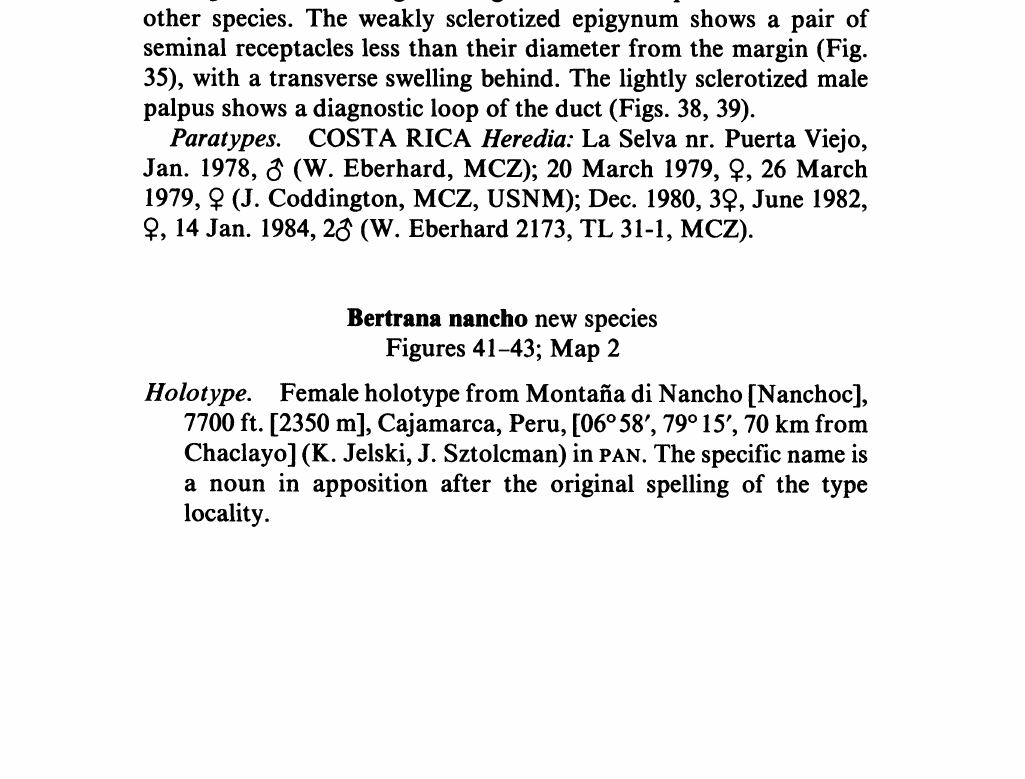
(Fig. 37). Posterior median eyes 0.9 diameter of anterior medians, laterals 0.8 diameter. Anterior median eyes diameter apart, 0.5 from laterals. Posterior median eyes their diameter apart, 1.2 from laterals. Abdomen spherical (Fig. 37). Total length 2.3 mm. Cara- pace 0.87 mm long, 0.84 wide. First femur 1.27 mm, patella and tibia 1.32, metatarsus 0.97, tarsus 0.48. Second patella and tibia 1.05 mm, third 0.84, fourth 1.06. Male paratype: Color as in female. Eyes subequal. Anterior median eyes slightly more than diameter apart, 0.4 from laterals. Posterior median